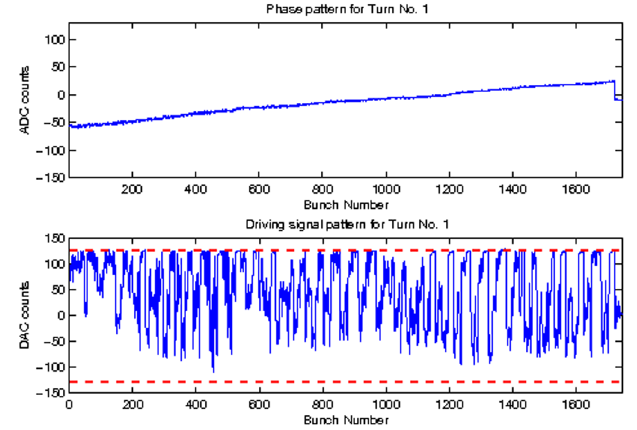
VIDEO 1. The animation shows the phase detected input signals, and the computed correction signals, for the transient studied in Figs. 8–15. The transient lasts 35 ms and noise saturated behavior leads to loss of control and loss of the beam.